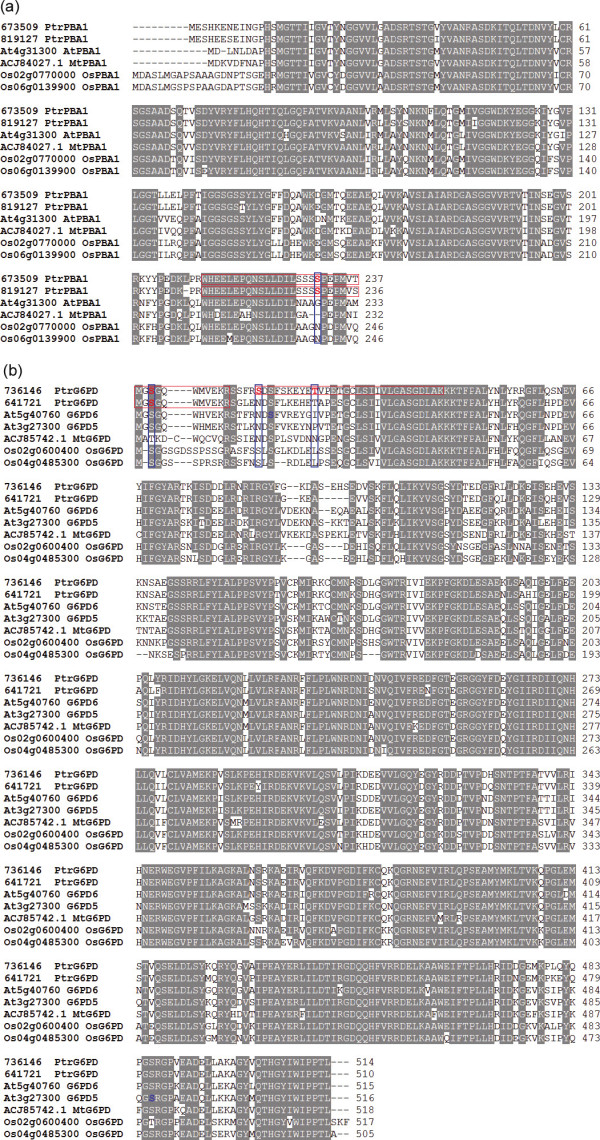
Sequence alignment of poplar phosphoproteins and their closest Arabidopsis homologs to identify unique phosphosites in poplar. Asterisk indicates phosphorylation site. Fine red boxes show phosphopeptides identified in this study. Phosphorylation sites identified from poplar in our study are shown in red bold font. Blue bold boxes show non-conserved phosphorylation sites. (a) Sequence alignment with all PBA1 orthologs. (b) Sequence alignment with all G6PD orthologs.